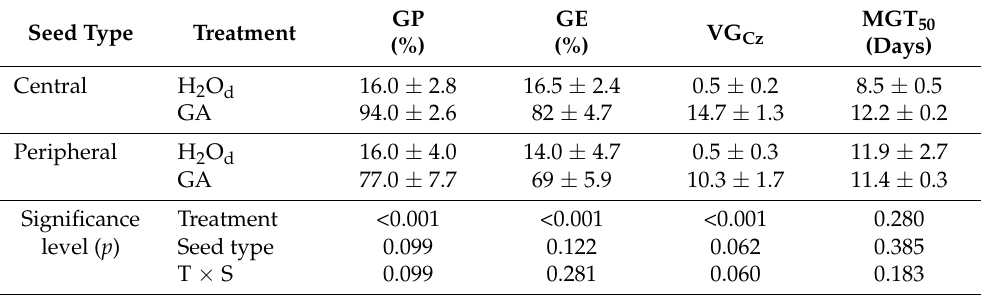
Table 7. Mean values ( ± SE) and significance level ( p ) of the germination parameters assessed in the greenhouse and under natural light, one month after collection and using seeds collected in June